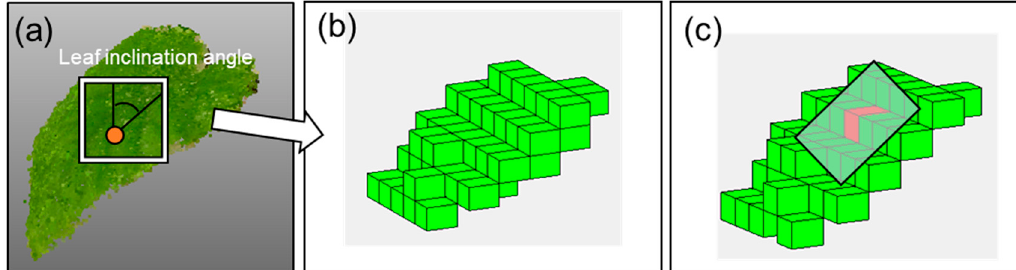
Figure 1. The leaf inclination angle estimation method. Panel ( a ) is a three dimensional (3D) leaf image, and it was converted into a voxel-coordinate as shown in the panel ( b ). The plane fitting was conducted around a voxel and all voxels with an attribute value of 1 among the 342 neighboring voxels (7 × 7 × 7 − 1) around the point (voxel) of interest as shown in the panel ( c ).